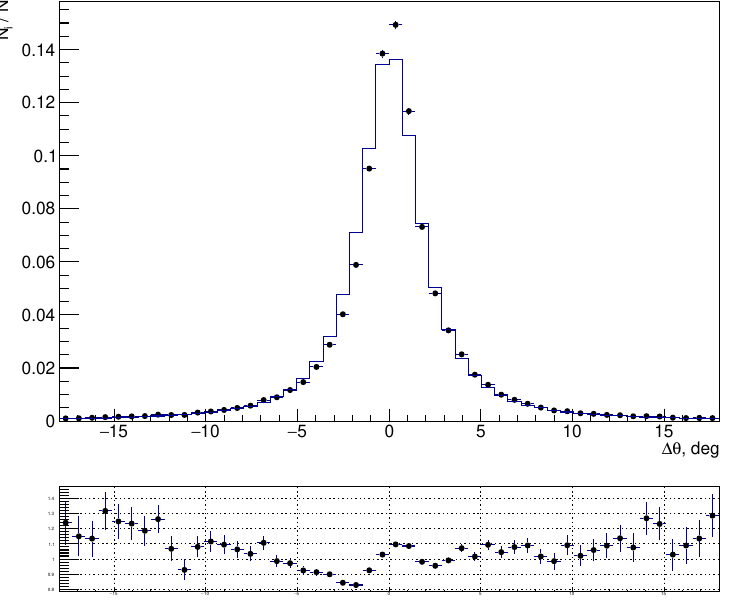
p s = 778 MeV. The solid histogram